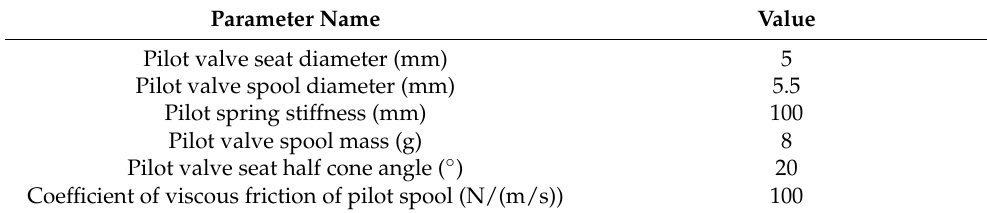
Table 1. Main parameters of relief